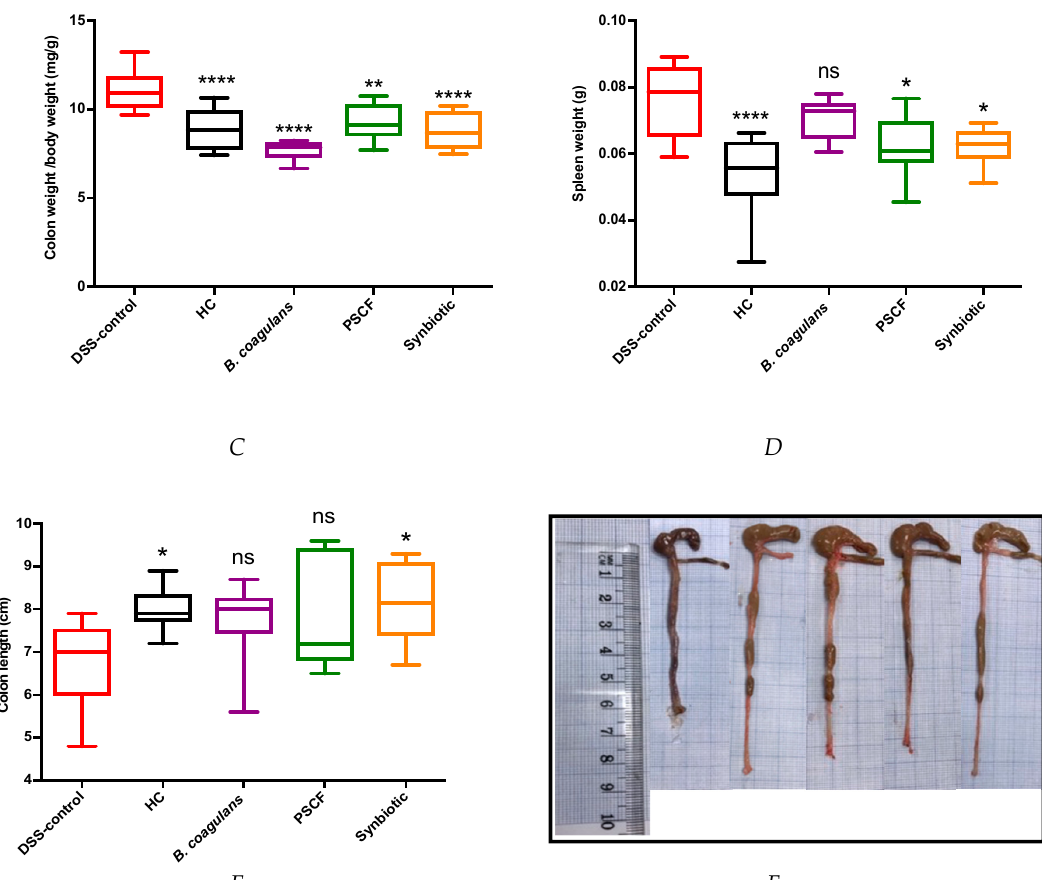
Figure 1. Effect of B. coagulans spores, PSCF and synbiotic in DSS-induced colitis model. ( A ) Disease Activity Index (DAI), ( B ) % body weight change. Statistical significance among groups evaluated by two-way repeated-measures analysis of variance (ANOVA) followed by Tukey’s test. * p < 0.05, ** p < 0.01, *** p < 0.001, **** p < 0.0001 vs. DSS-control group and data expressed as mean ± SEM ( n =10 per group). Colon weight/body weight ratio ( C ), Spleen weight ( D ), Colon length ( E ) and Macroscopic appearance of colon ( F ). Data expressed as mean ± SEM ( n =10 per group), evaluated by one-way